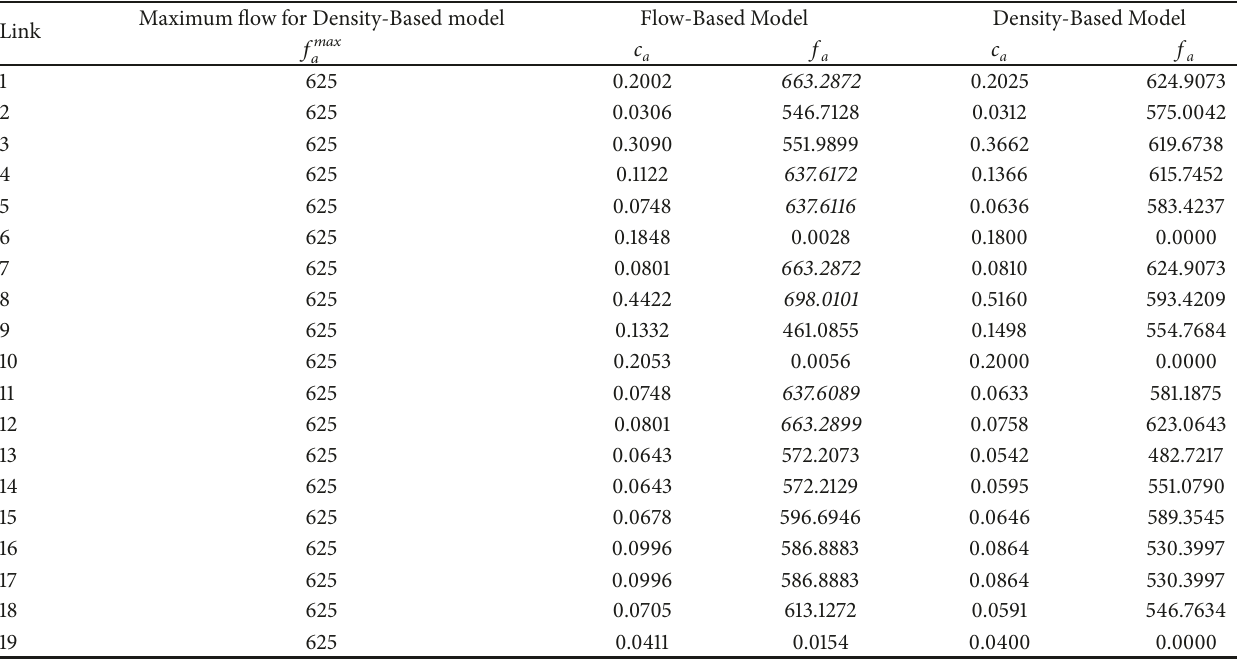
Table 7: Equilibrium Link Assignments, Both Approaches (high